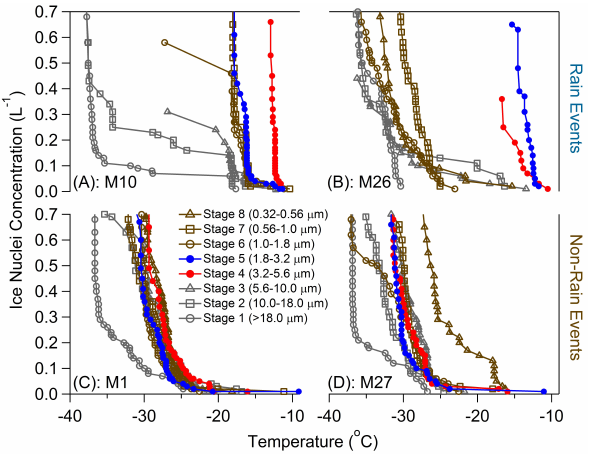
Fig. 5. IN activation curves from microscopic IN activation experi- ments with size-resolved aerosol samples (MOUDI stages). Upper panels (A, B) for samples collected during rain events, and lower panels (C, D) for samples collected during dry periods. Red traces show Stage 4 (3.2–5.6µm), blue traces show Stage 5 (1.8–3.2µm), brown traces show Stages 6–8, and gray traces show Stages 1–3. See SOM Sect. S1.4.1.1 for sampling dates.